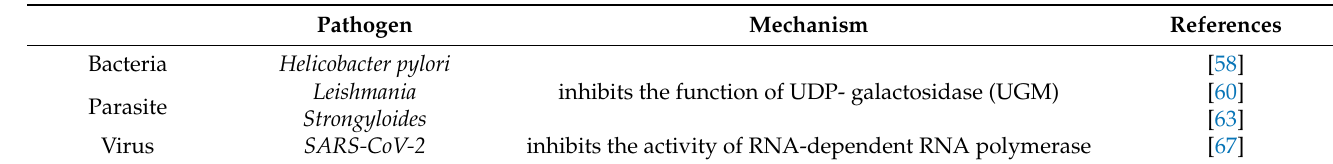
Table 3. Antipathogen activities of